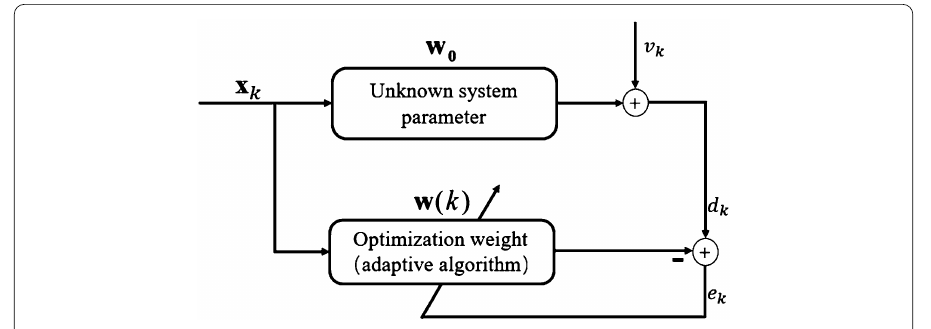
Figure 1 Adaptive algorithm signal